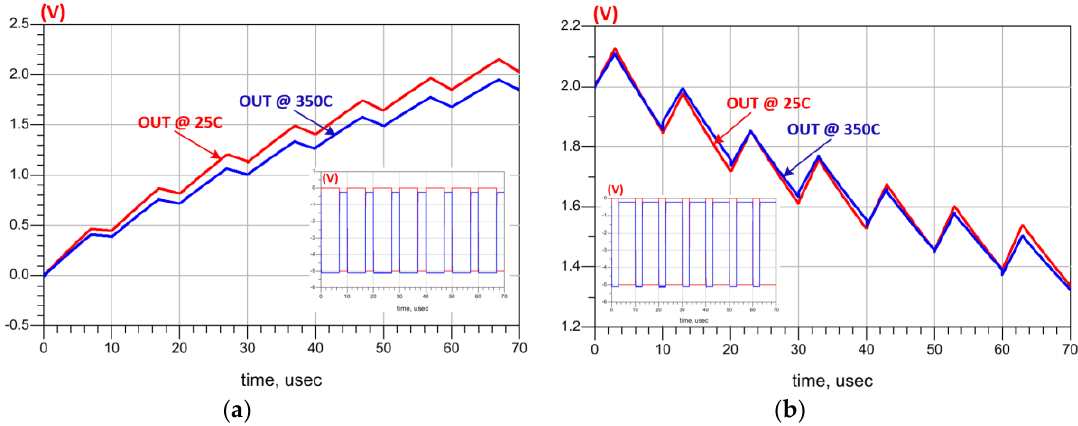
Figure 12. Impact of the temperature on Charge pump during: ( a ) Charging; ( b ) Discharging.